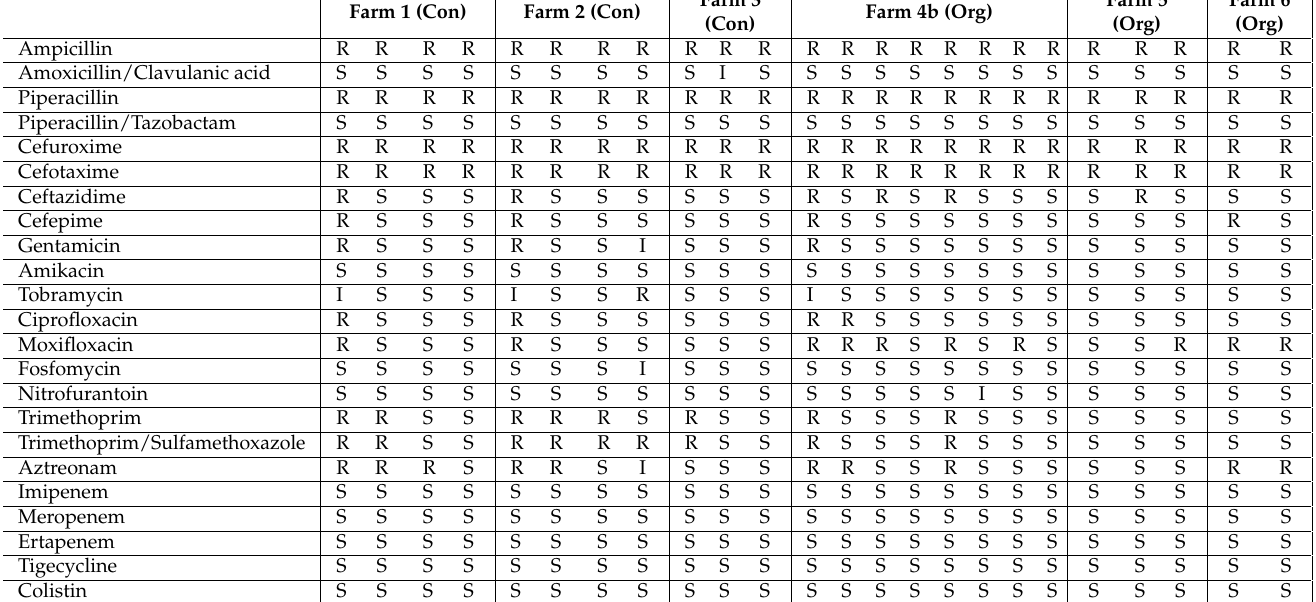
Table 3. Resistance profiles in the VITEK 2 Compact study of 51 isolates derived from pigs in finishing fattening ( ≥ 90 d in fattening). Isolates with identical results in AST from one farm were summarized to a resistance profile. (Con = conventional farm; Org = organic farm, S = sensitive, I = intermediate, R =